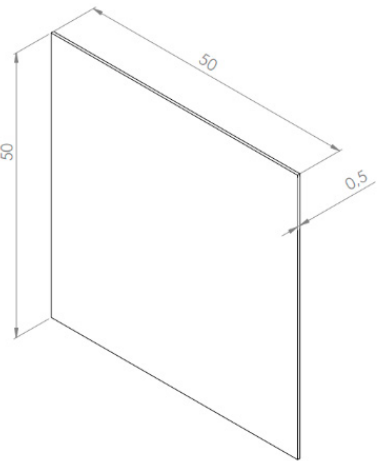
Figure 1. 3D CAD sample, dimensions in mm .